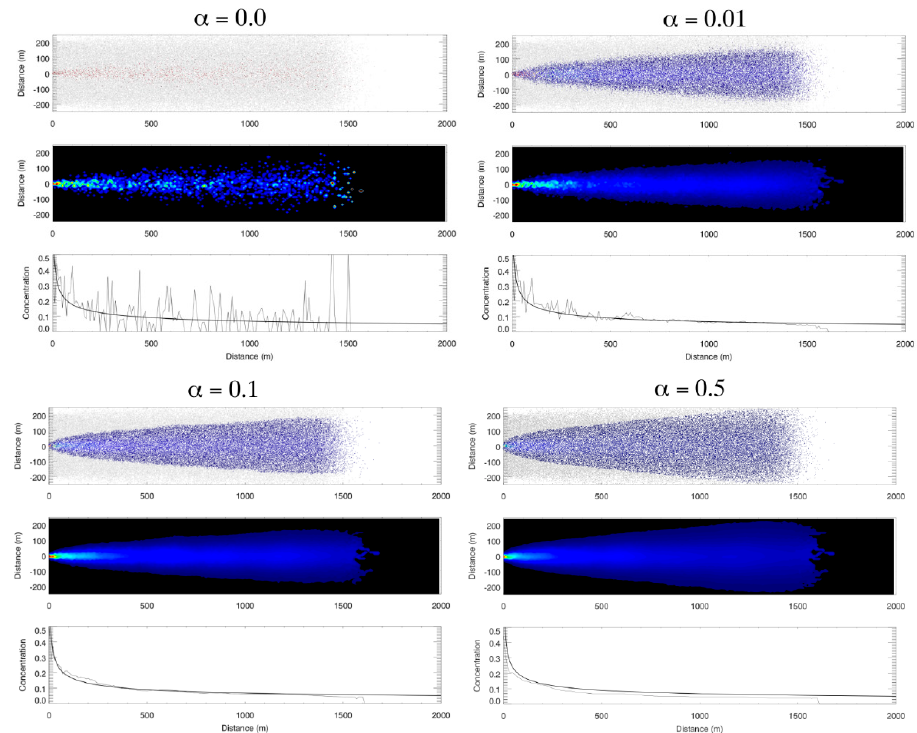
Figure 5. PCPM simulation of concentration plume in an idealized channel with four different values of the cell-based redistribution weight parameter ( α = 0, 0.01, 0.1, 0.5). There are three panels for each value of α . The top panel shows the locations of particles after 720 time steps (12 min). The second panel shows the average concentration in each 10 m square cell with the same blue to red scale as the top panel, except cells with C = 0 are black. The third panel compares concentration along the center line of the plume from the second panel to the analytical solution for a diffusive plume.